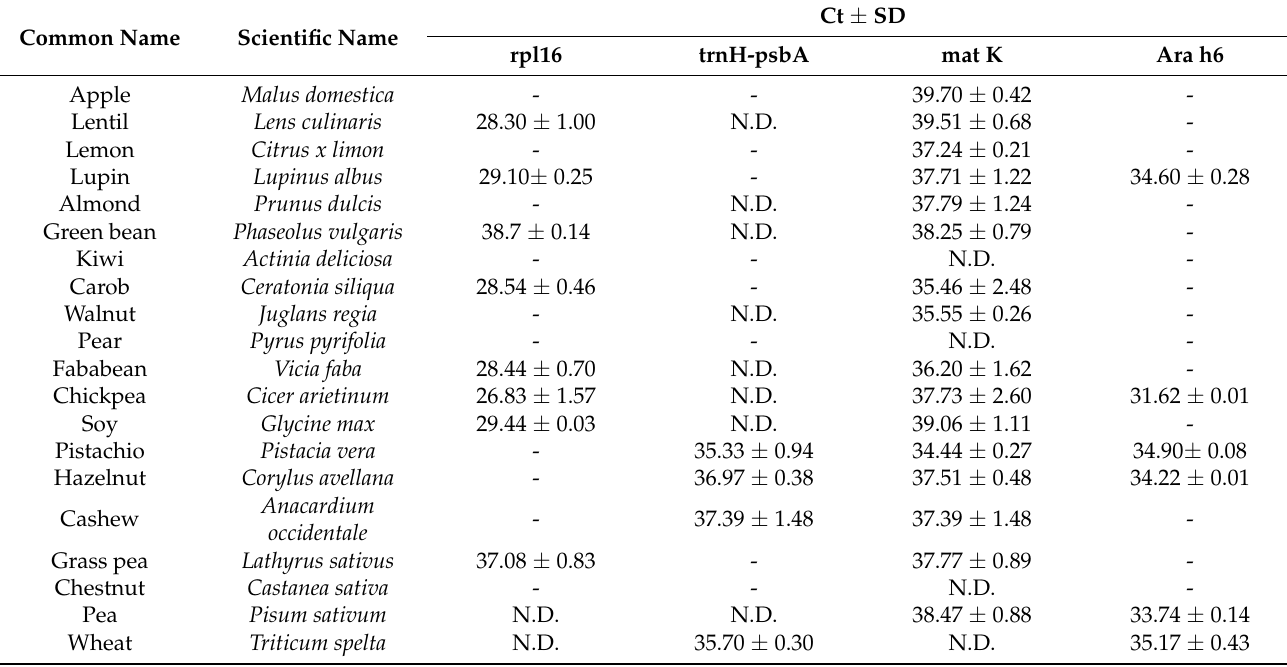
Table 3. Specificity of the three selected targets. In addition, 10 ng of DNA from different plant species was assayed at least in triplicate. Protocol 1 was used to obtain genomic DNA. N.D. not detected. “-not